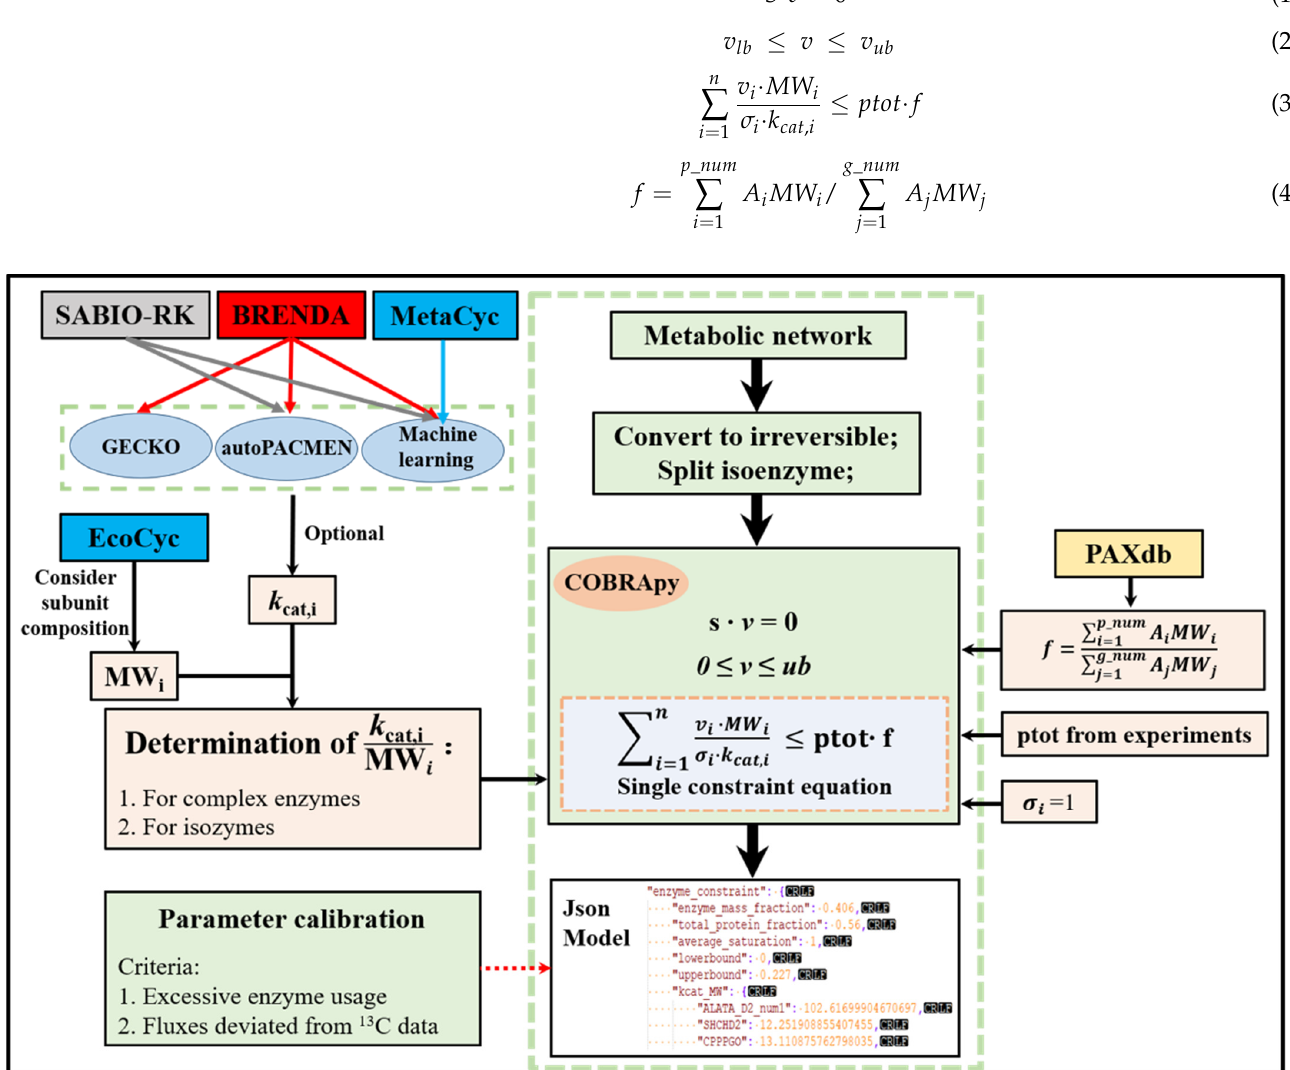
Figure 1. The ECMpy Workflow for Construction of Enzyme-constrained